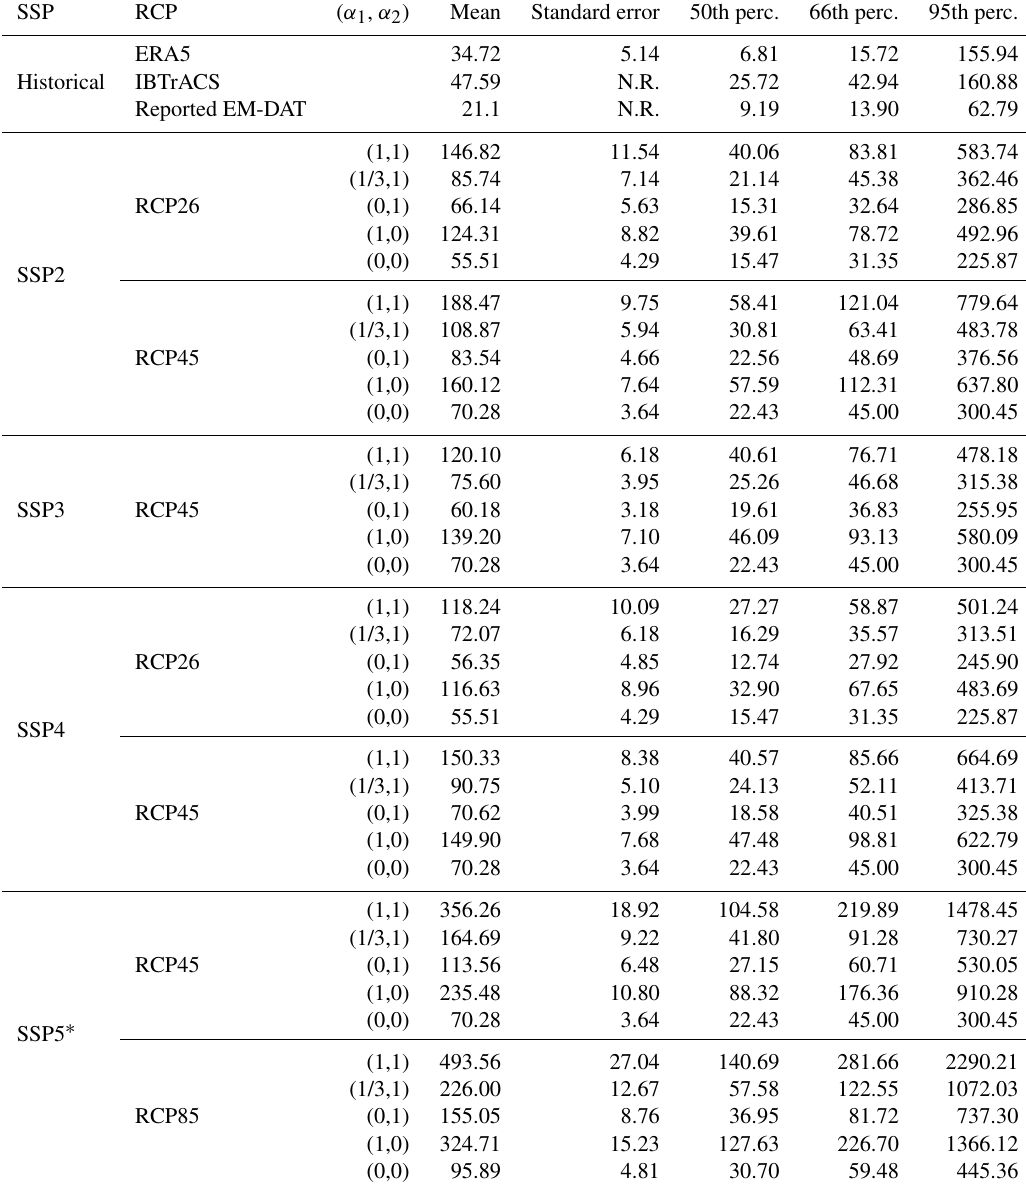
Table 4. Simulation statistics (in USD